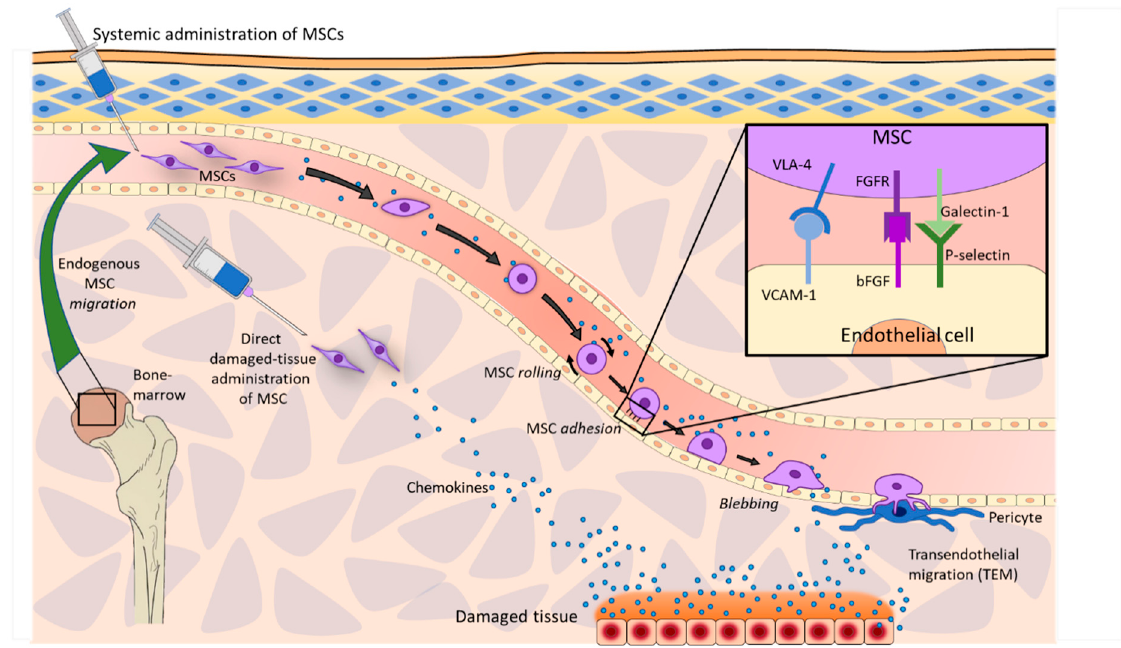
Figure 1. Homing and transendothelial migration of mesenchymal stromal cells (MSCs). MSCs can act both endogenously or exogenously, performing a homing process, by which they move towards the affected site following chemotactic signals in order to repair or contribute to the recovery of the damaged tissue. bFBF: basic fibroblast growth factor; FGFR: fibroblast growth factor receptors; VLA-4: very late antigen 4; VCAM-1: vascular cell adhesion molecule 1.